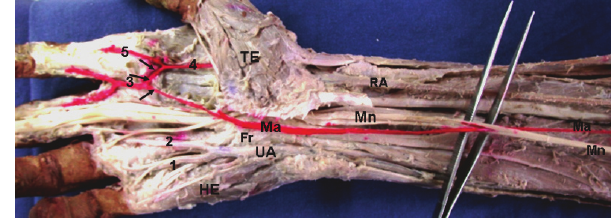
Figure 1 - Ventral aspect of the distal third of the forearm and hand. Fr, flexor retinaculum; HE, hypothenar eminence; Ma, median artery; Mn, median nerve; RA, radial artery; TE, thenar eminence; UA, ulnar artery; 1 & 2, common palmar digital arteries originating from the ulnar artery; 3, common palmar digital arteries originating from the superficial palmar arch; 4, arteria radialis indicis; 5, proper palmar digital artery to the radial side of the index finger. Note that the black arrows indicate the superficial palmar